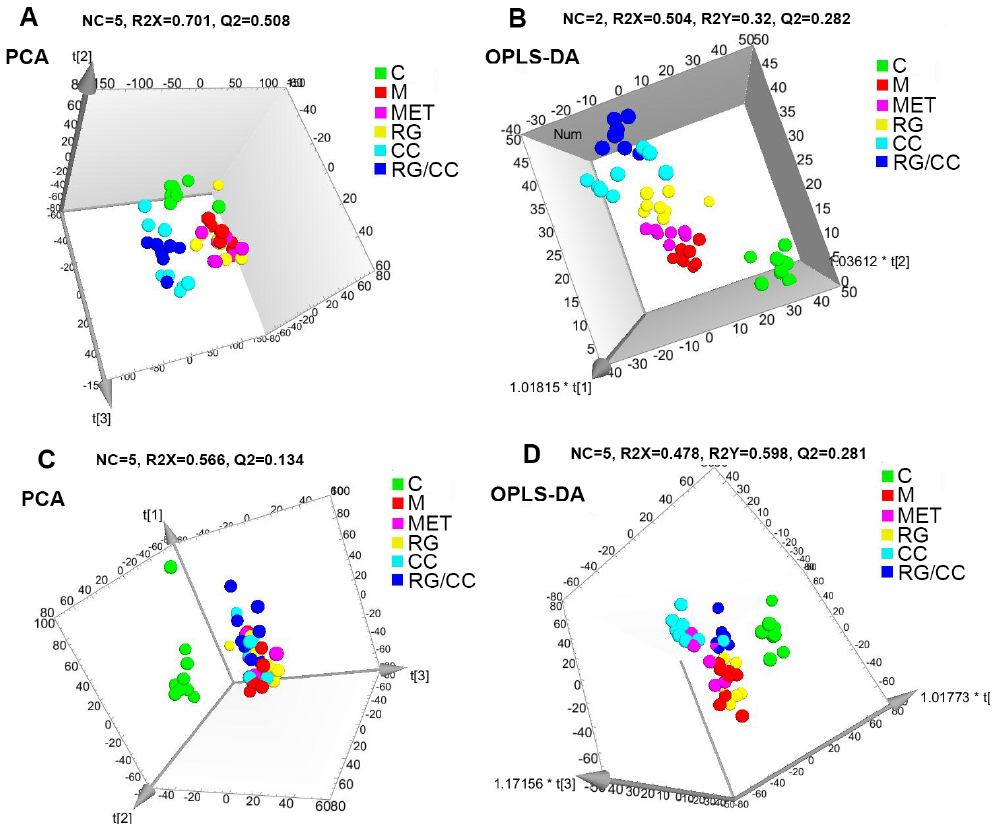
Figure 5. Different groups of serum metabolites visualized using PCA and OPLS-DA score plots. ESI + mode: ( A , B ); ESI − mode: ( C , D ). NC represented the number of components. R2X and R2Y were cumulative modelled variation of all R2Xs and R2Ys, separately, and Q2 was the cumulative predicted fraction. p CV-ANOVA values for OPLS-DA models ( B , D ) were 4.42718 × 10 −8 and 0.0105384, respectively.